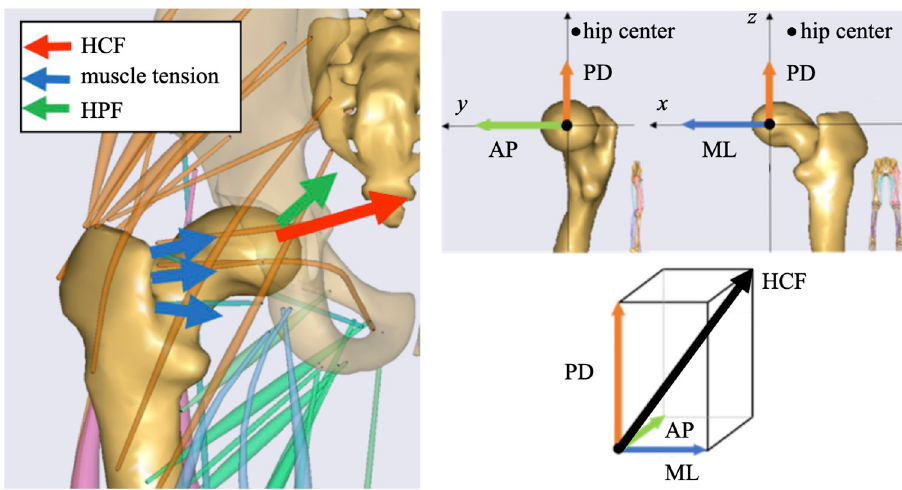
Fig 5. Hip joint diagram for the calculation of muscle contribution to the HCF. The hip penetration force was the force exerted by an adjacent body segment. Muscle tension alone contributed to the HCF. Using the inverse dynamics analysis, the HCF was calculated using three components: anterior/posterior (AP), proximal/distal (PD), and medial/ lateral (ML). The HCF was calculated by combining these three force vectors.